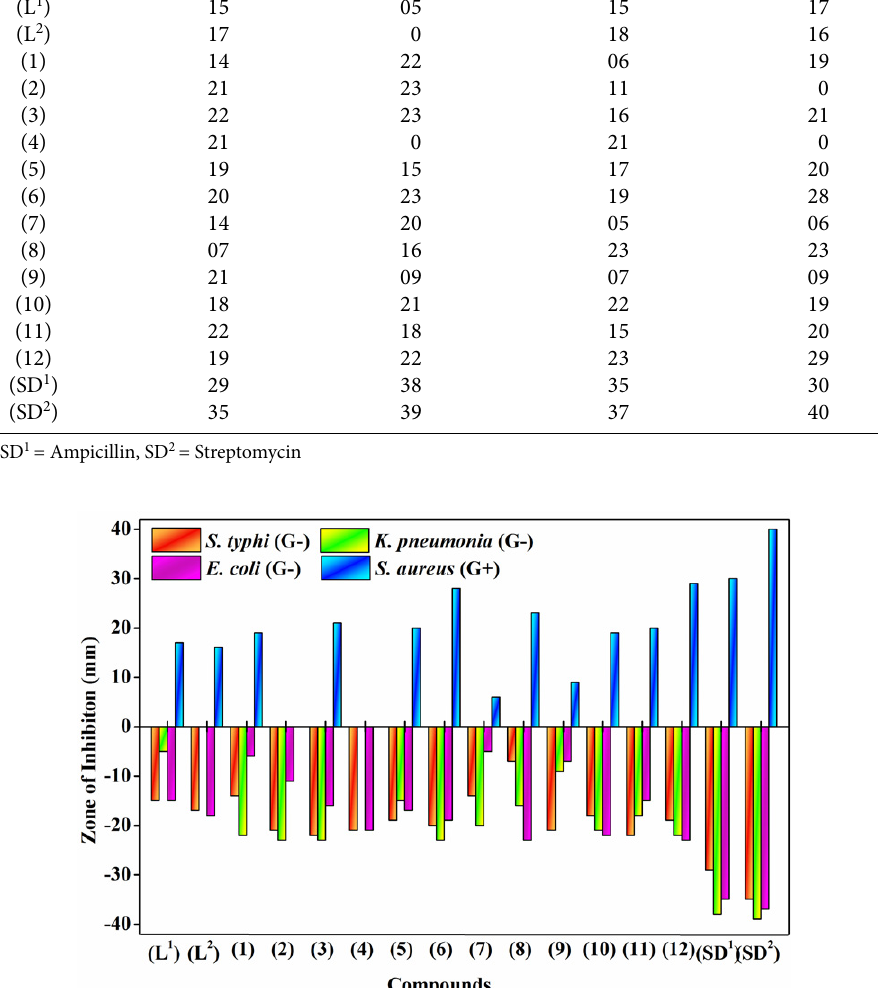
Table 4. Antibacterial activity (inhibition zone/mm) of ligands and their metal complexes Salmonella Klebsiella Escherichia Staphylococcus Compounds